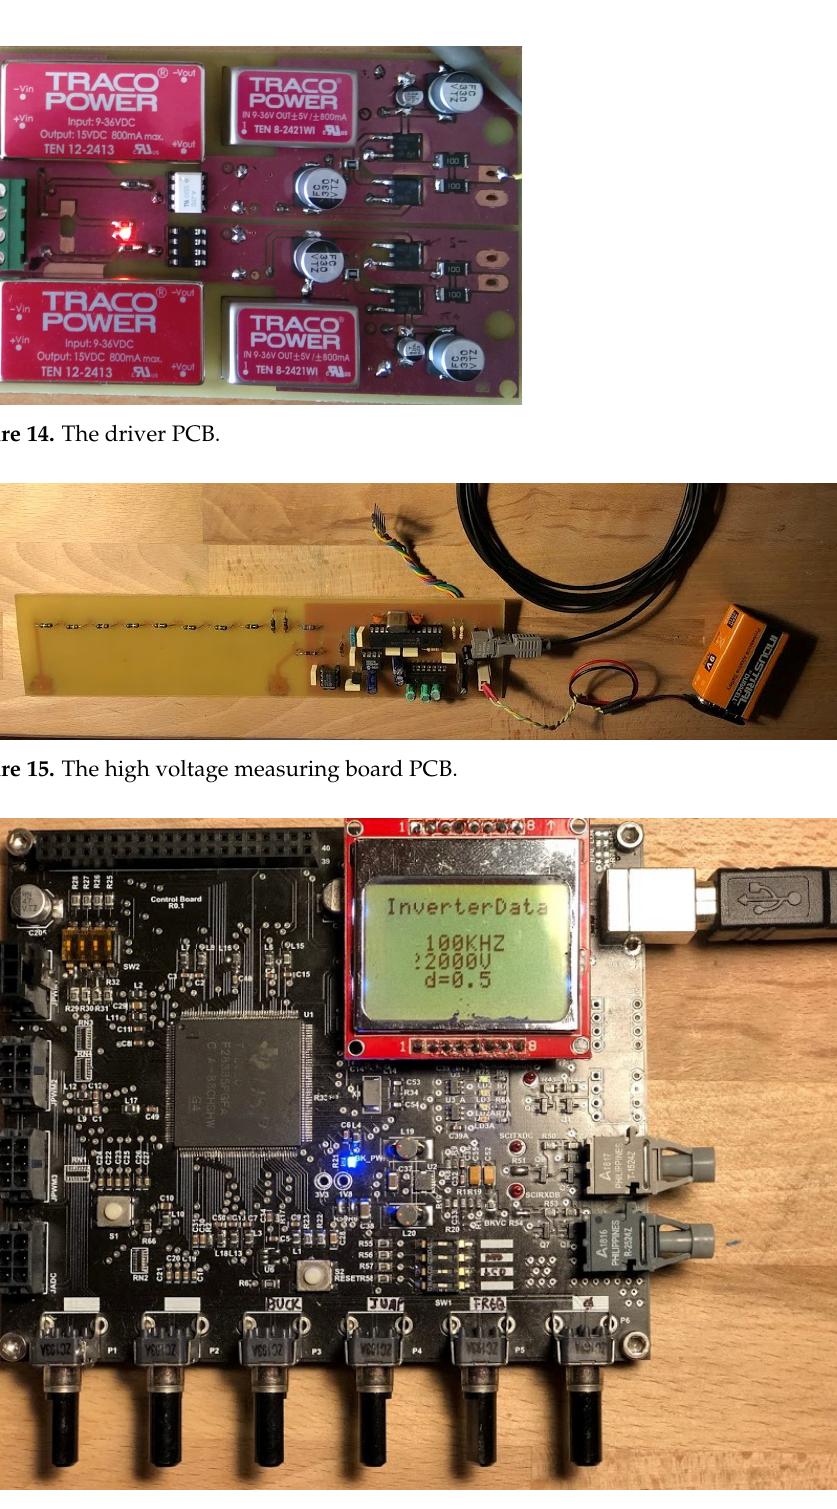
Figure 16. The control